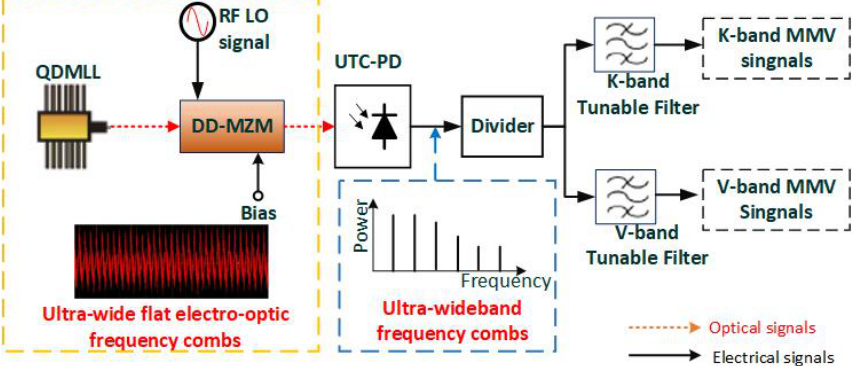
Figure 1. Schematic architecture of the tunable multi-tone 5G+ MMW frequency synthesizer using ultra-wide broadband electro-optic frequency